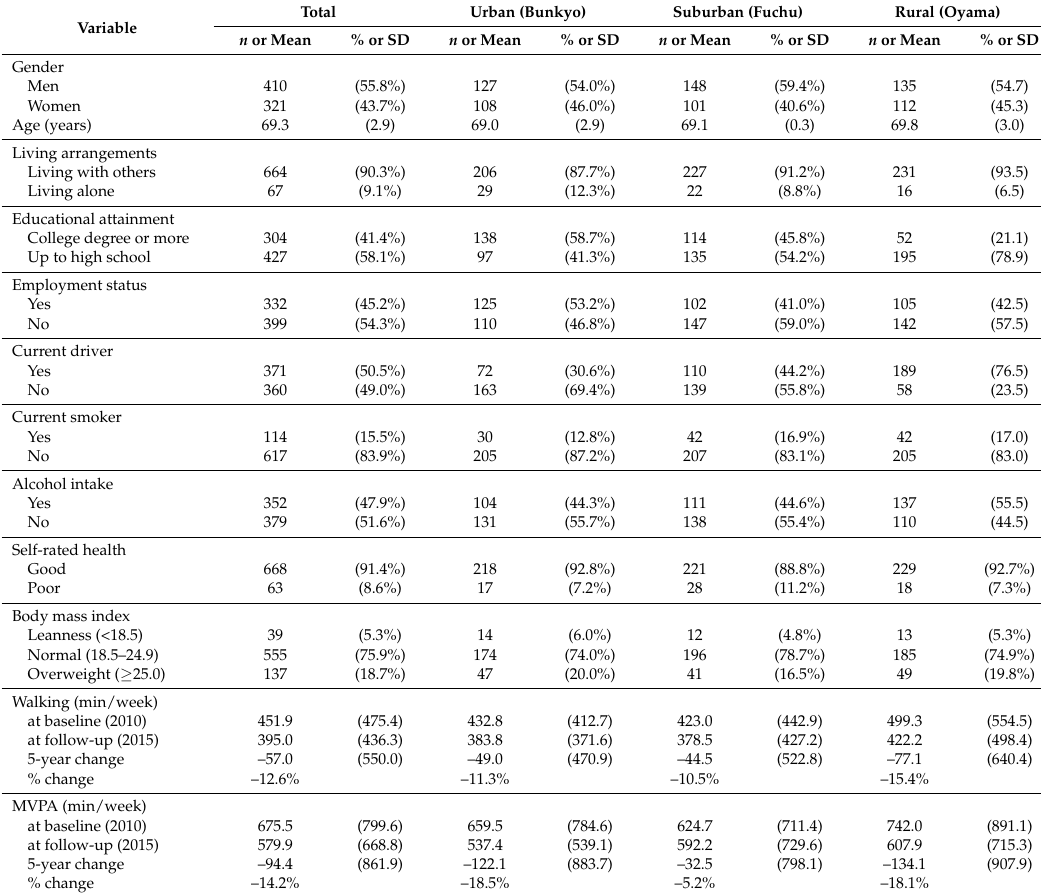
Table 1. Baseline characteristic of participants.